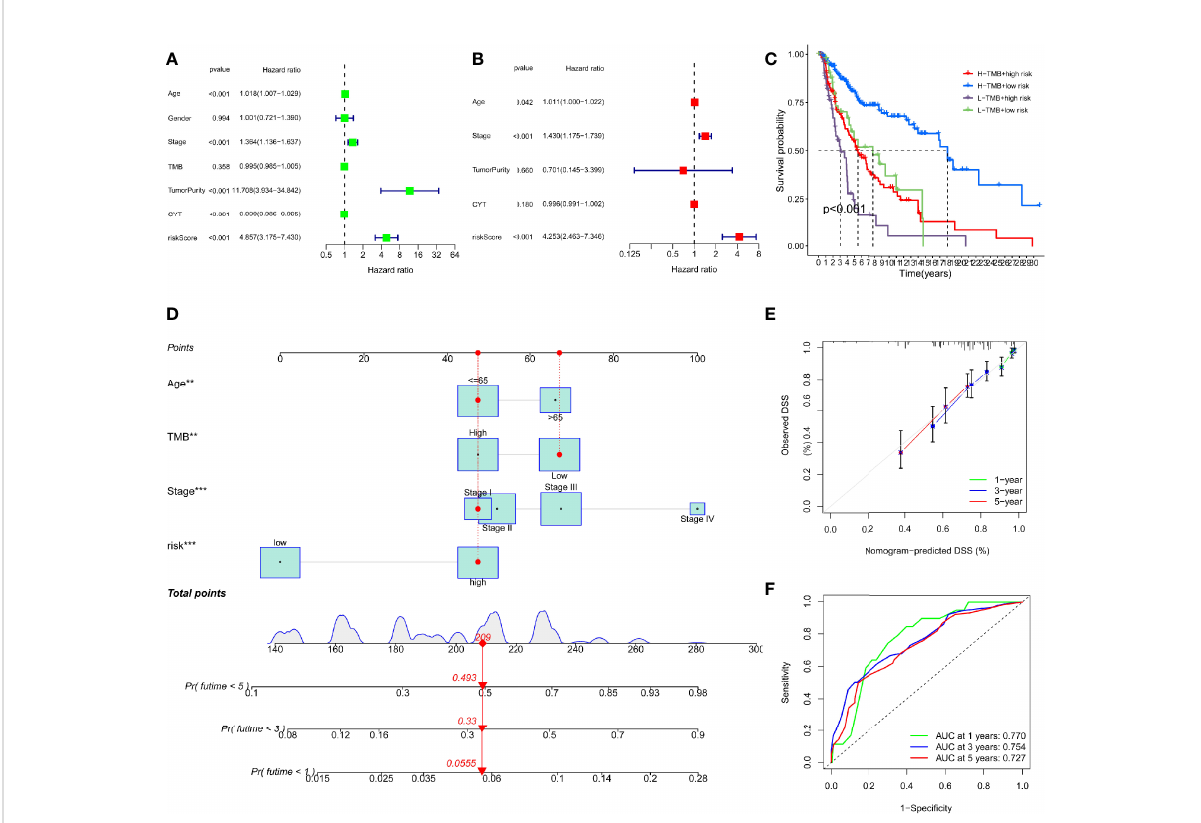
FIGURE 5 Construction of a nomogram based on the DRRGs signature. (A) The univariate Cox analysis illustrated that the age, stage, tumorpurity, CYT and riskScore were statistically distinct; (B) The multivariate cox analysis illustrated the age, stage and riskScore were 3 independent predictors of SKCM prognosis; (C) Survival curve for patients with distinct TMB and risks; (D) The nomogram integrated with the parameters (riskScore, stage, and age) amongst patients from the TCGA cohort; (E) Calibration curve of the nomogram at 1, 3, and 5 years; (F) AUC values for 1-, 3-, and 5- year survival rates premised on the